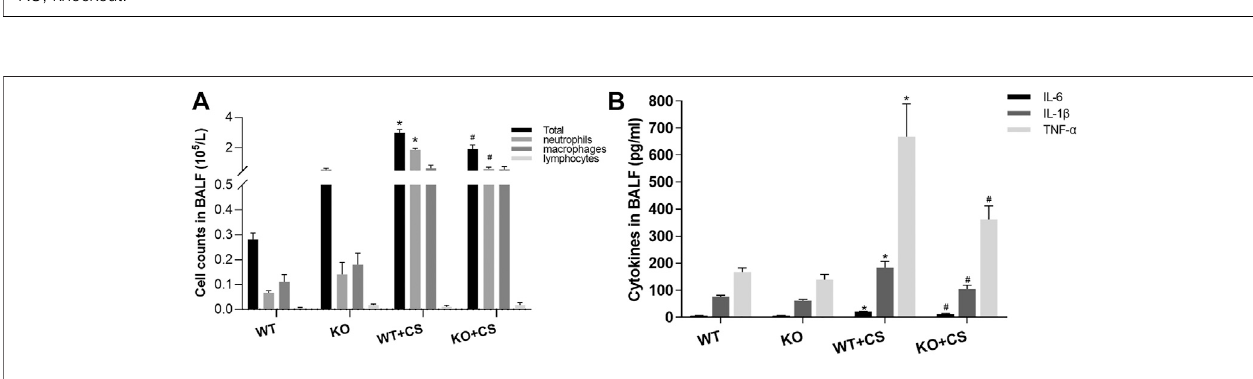
Frontiers in Pharmacology |